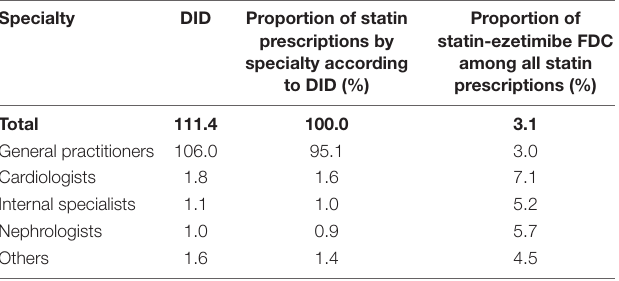
TABLE 2 | Prescription of statins in DID and proportion of statin-ezetimibe FDC by specialty